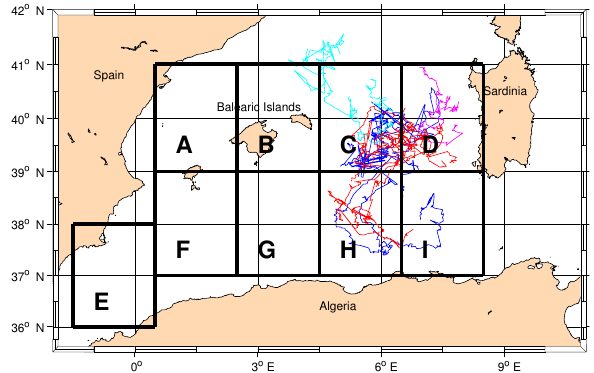
Figure 14. Number of long-life anticyclonic eddies formed (red bars) and terminated (blue bars) in each sector. The yellow bars indicate the structures formed and terminated in the same sector.